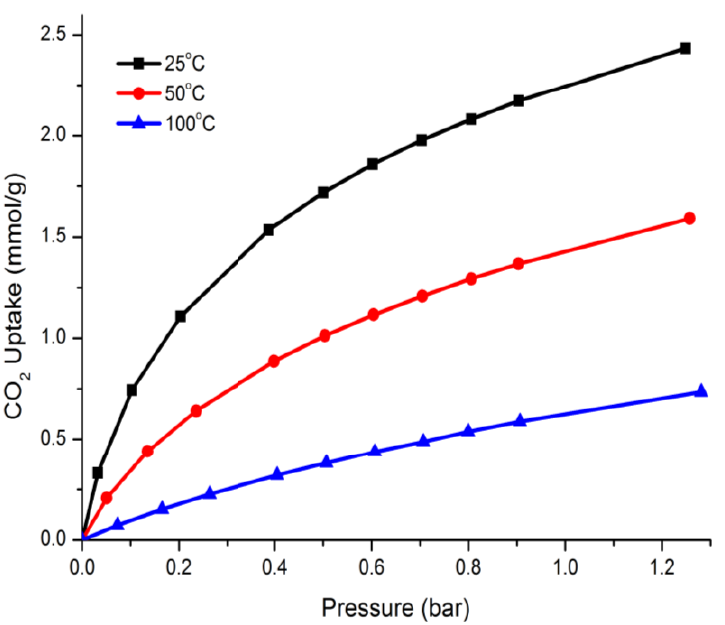
Figure 9. CO 2 adsorption isotherm of sample RSS-IL 800 at the temperatures of 25, 50, and 100 °C. Additionally, FTIR analysis was conducted on the sample RSS-IL 800 before and after CO 2 adsorption, as shown in Figure 10. Sample RSS-IL 800 exhibited a similar chemical spectrum before and after adsorption. However, the peak intensity of the sample after the adsorption process was increased. A new peak was also observed. The analysis indicates that the RSS-IL 800 sample is thermally stable during the adsorption process. The peaks appearing at 3424, 1736, 1635, 1062, 800 and 600 cm −1 are the bonds that might help in the interaction between the AC and CO 2 gas molecules during the absorption process. The new small peak found at 2300 cm −1 corresponds to the physisorption of CO 2 molecules [58].